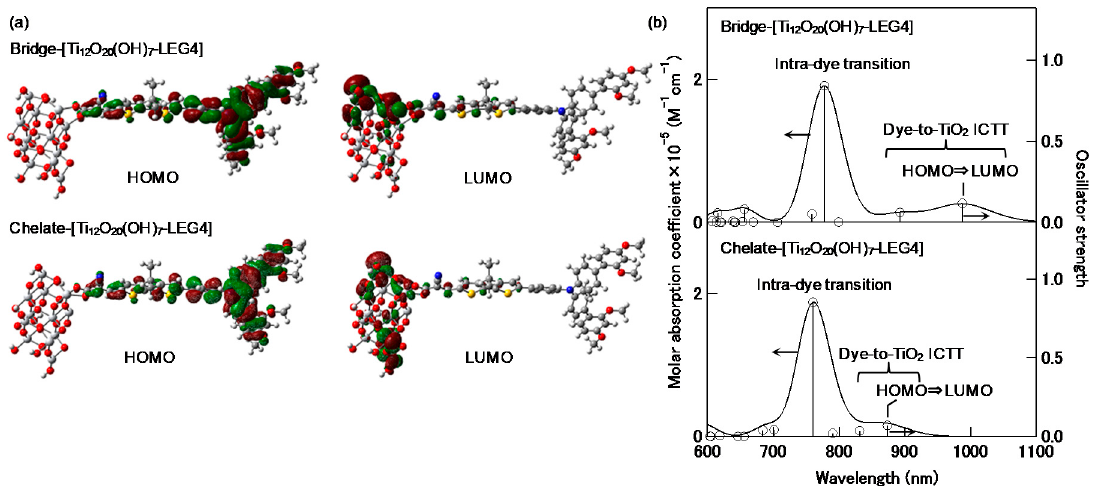
Figure 11. ( a ) Isosurface plots of HOMO and LUMO and ( b ) TD-DFT calculated electronic excitation spectra of bridge- and chelate-type TiO 2 -LEG4 model complexes. Adapted with permission from Reference 3. Copyright 2018 American Chemical Society.